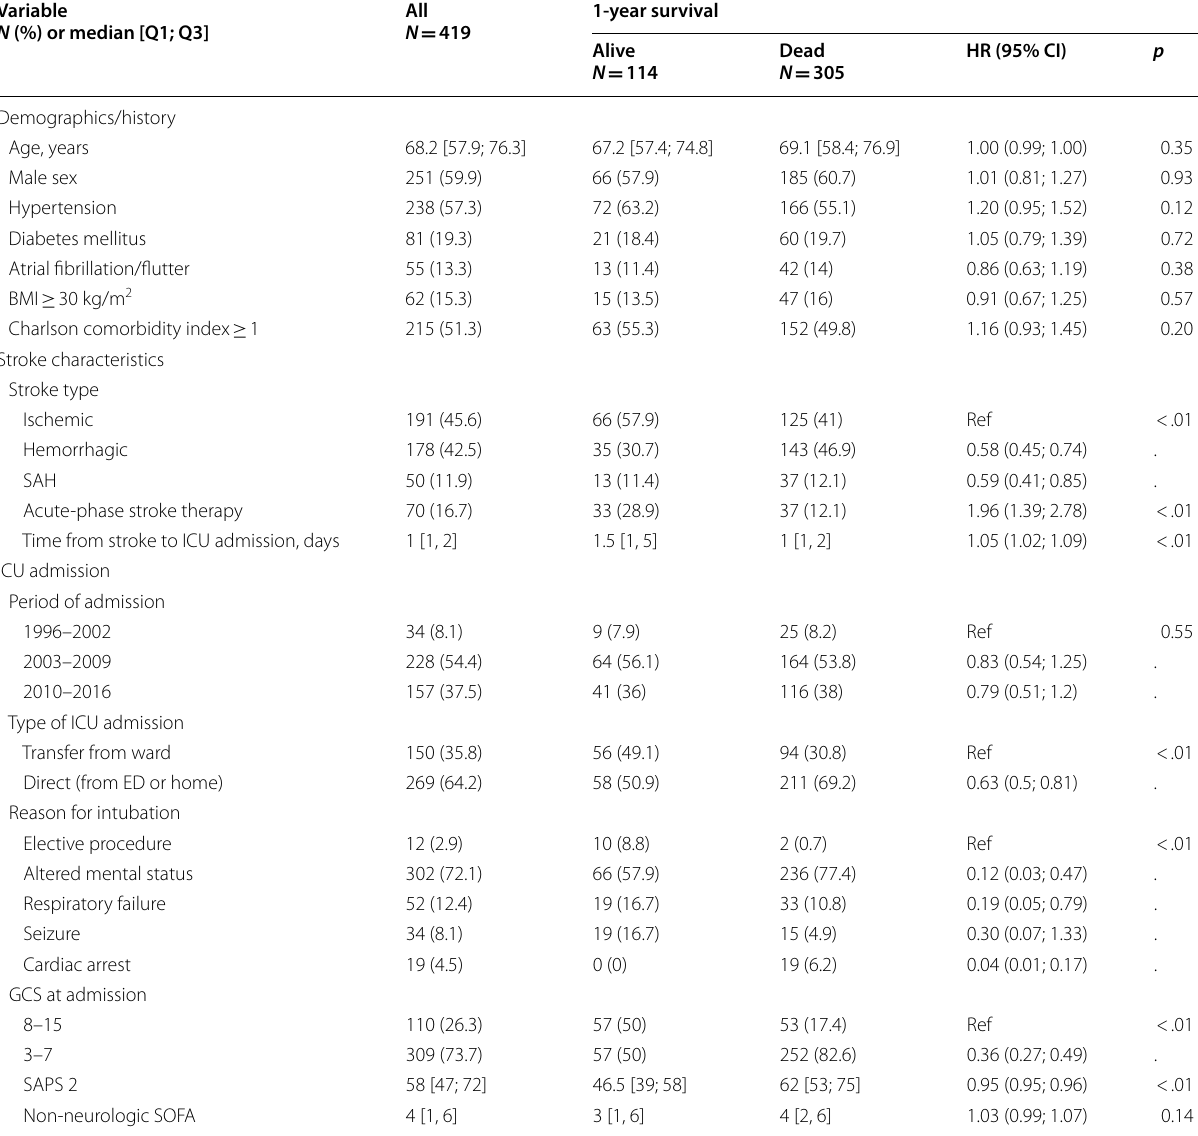
Table 1 Baseline characteristics and their univariate association with 1-year survival tested by Cox proportional hazard